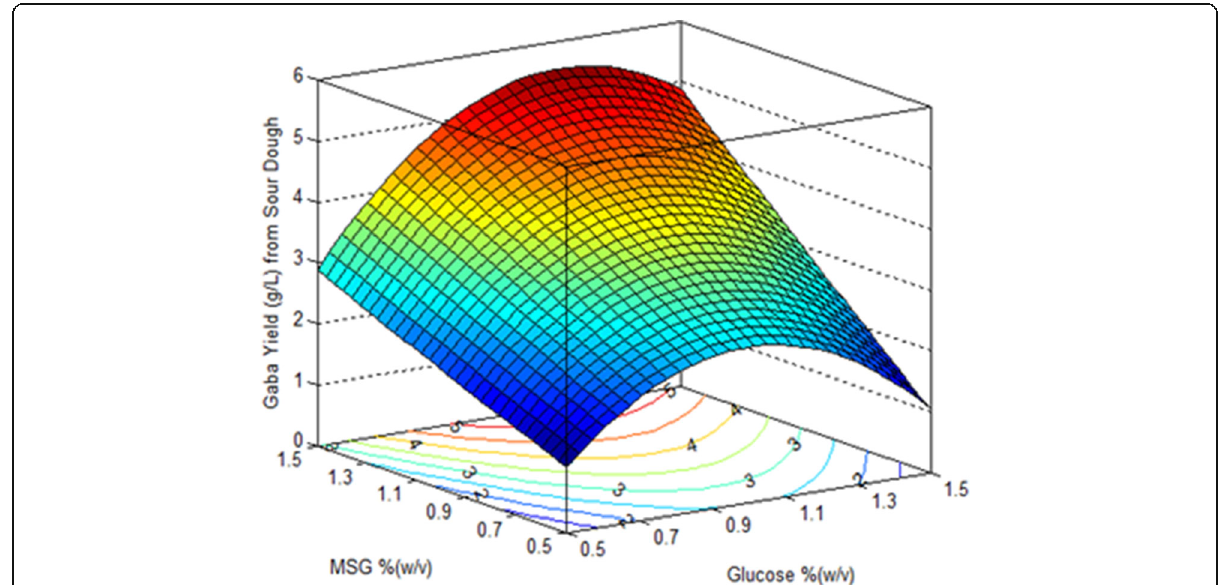
Fig. 4 3D plot for interactive effect of glucose and MSG concentration on the GABA Yield (g/L) by Lb. fermentum keeping incubation period at its constant central level (0)